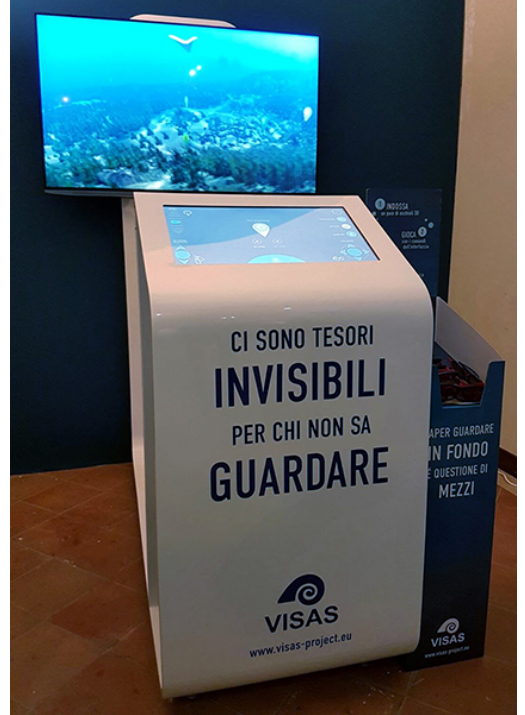
Figure 10. Final setup of the VR system